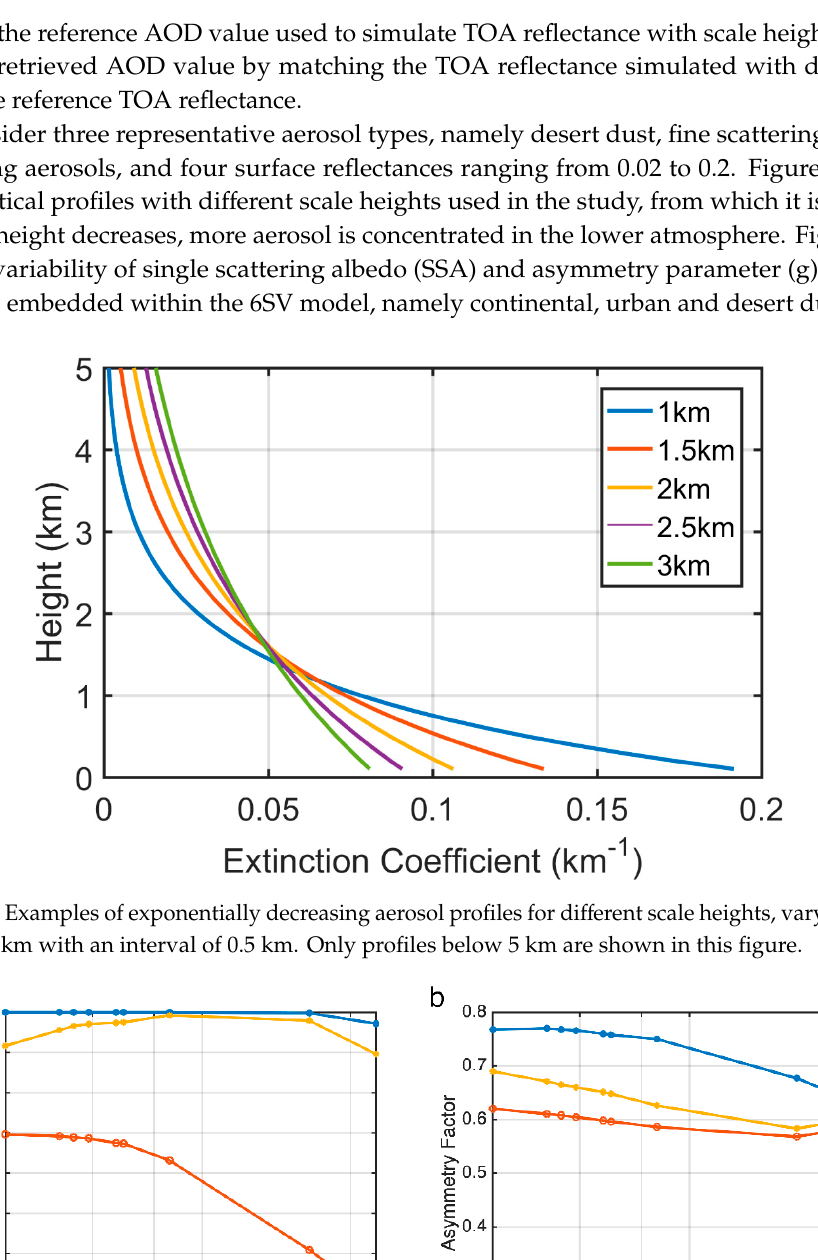
Figure 2. Spectral dependence of single scattering albedo ( a ) and asymmetry factor ( b ) for three aerosol models embedded in the 6SV radiative transfer model.